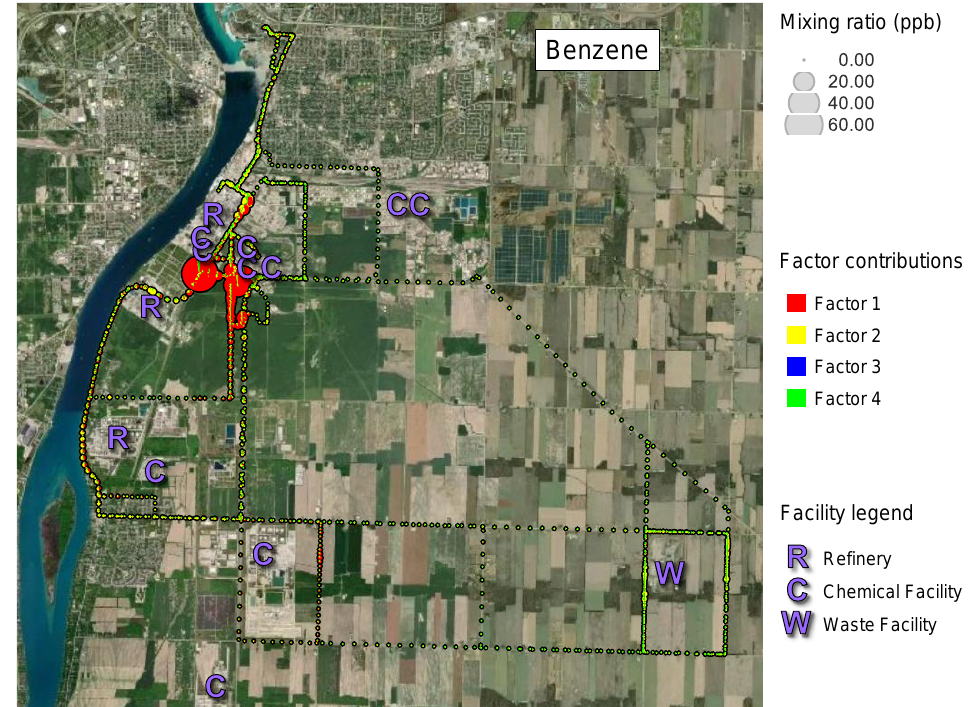
Figure 4. Contributions of each of the four local factors to benzene mixing ratios as a function of measurement location while mobile. The diameter of each pie denotes the benzene mixing ratio and the size of each wedge within each pie represents the relative contribution of each factor for that measurement period.